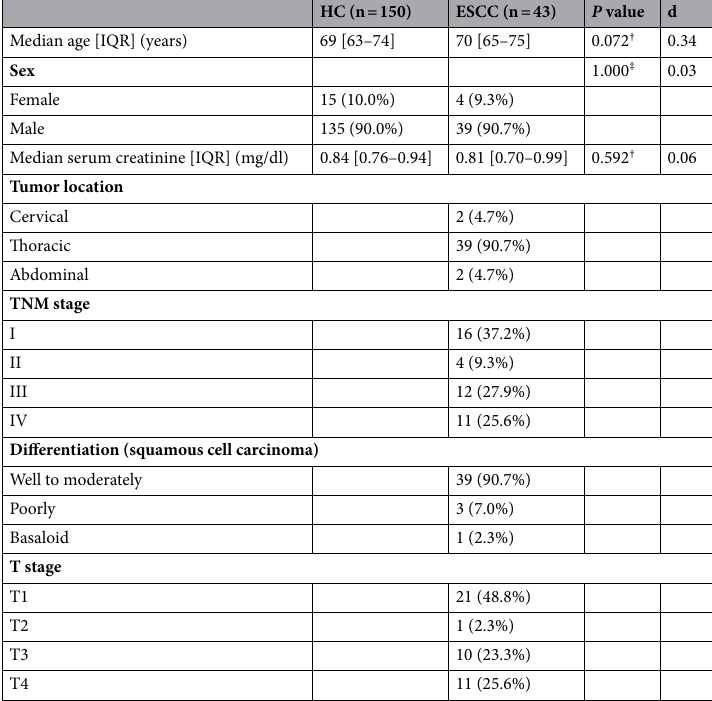
Table 1. Characteristics of the whole analysis cohort. HC healthy control; ESCC esophageal squamous cell carcinoma; IQR interquartile range; d standardized difference. † Mann–Whitney U test. ‡ Fisher’s exact probability